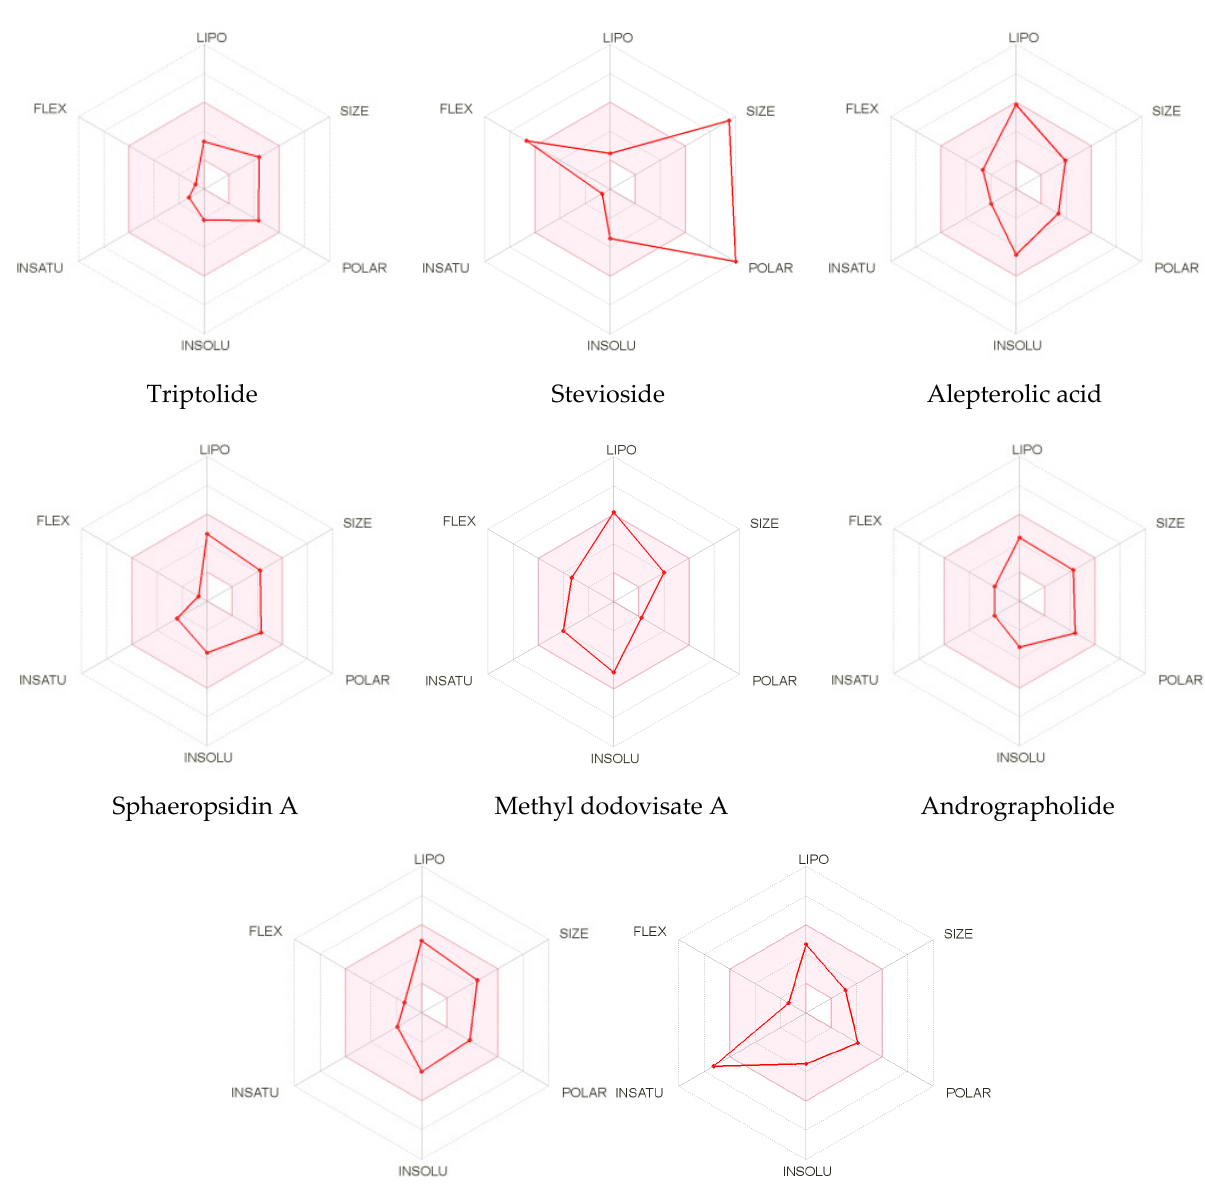
Figure 2. Summary of physiochemical, pharmacokinetics, and toxicological properties of selected ligand candidates (the color space is a suitable physiochemical space for oral bioavailability; LIPO ( Lipophility ): –0.7 < XLOGP3 < 5.0; SIZE : 150 g/mol < MW < 500 g/mol; POLAR ( Polarity ): 20 Å 2 < TPSA < 130 Å 2 ; INSOLU ( insolubility ): 0 < LogS(ESOL) < 6; INSATU ( in saturation ): 0.25 < FractionCsp3 < 1; FLEX ( Flexibity ): 0 < Num. rotatable bonds < 9).